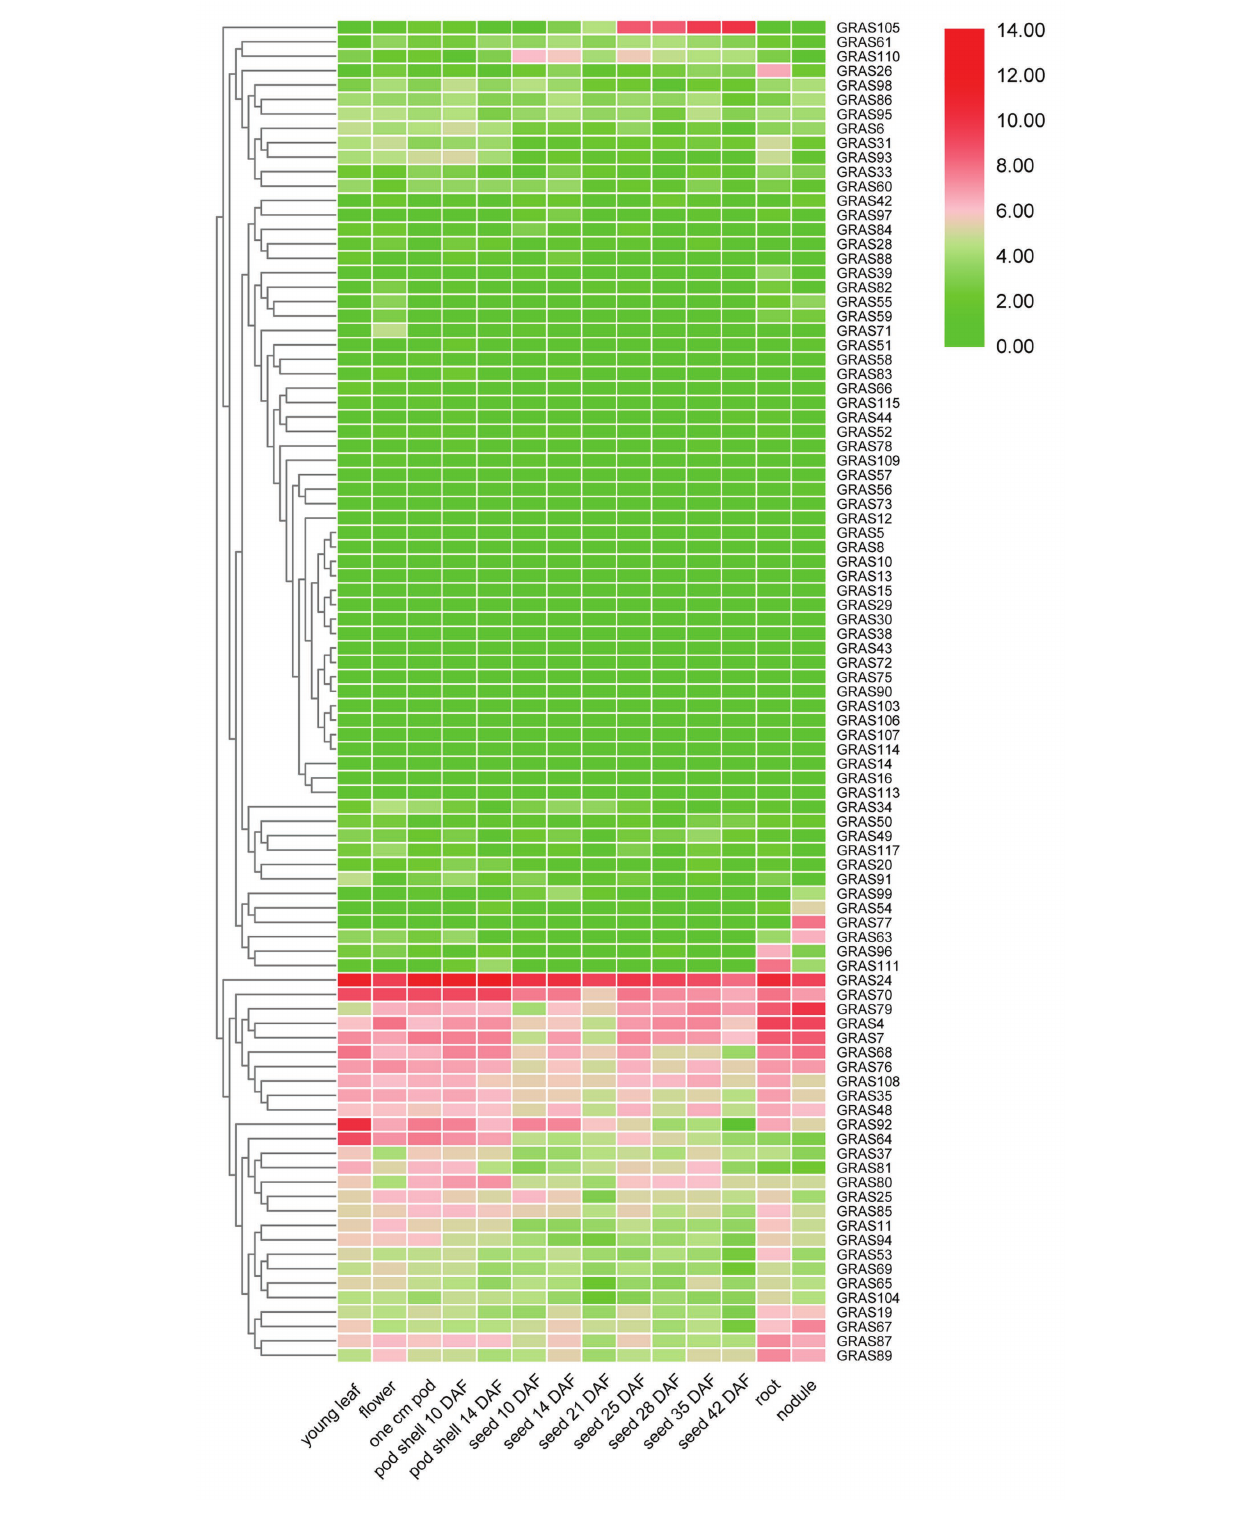
FIGURE 8 | Heat map of the expression profiles of all GmGRAS genes in different soybean tissues. The expression abundance (in log10-based FPKM) of each transcript is represented by the color: red, higher expression; green, lower expression. Expression levels in 14 different tissues are shown: young leaves, flowers, one cm pods, pod shells at different days after flowering (DAF), roots, and